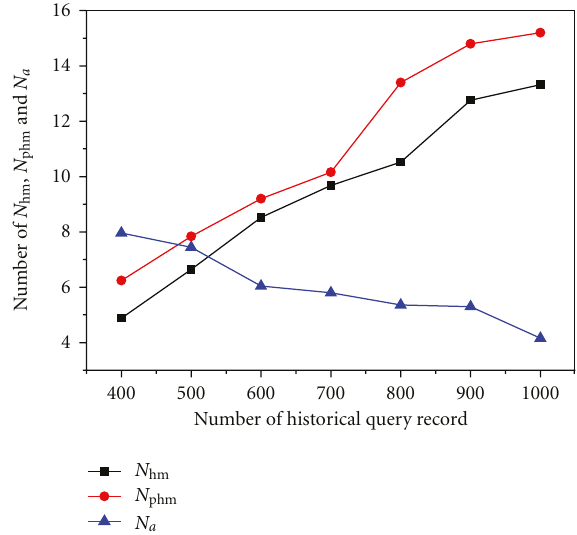
Figure 10: Impact of region size on N hm , N phm and N a .